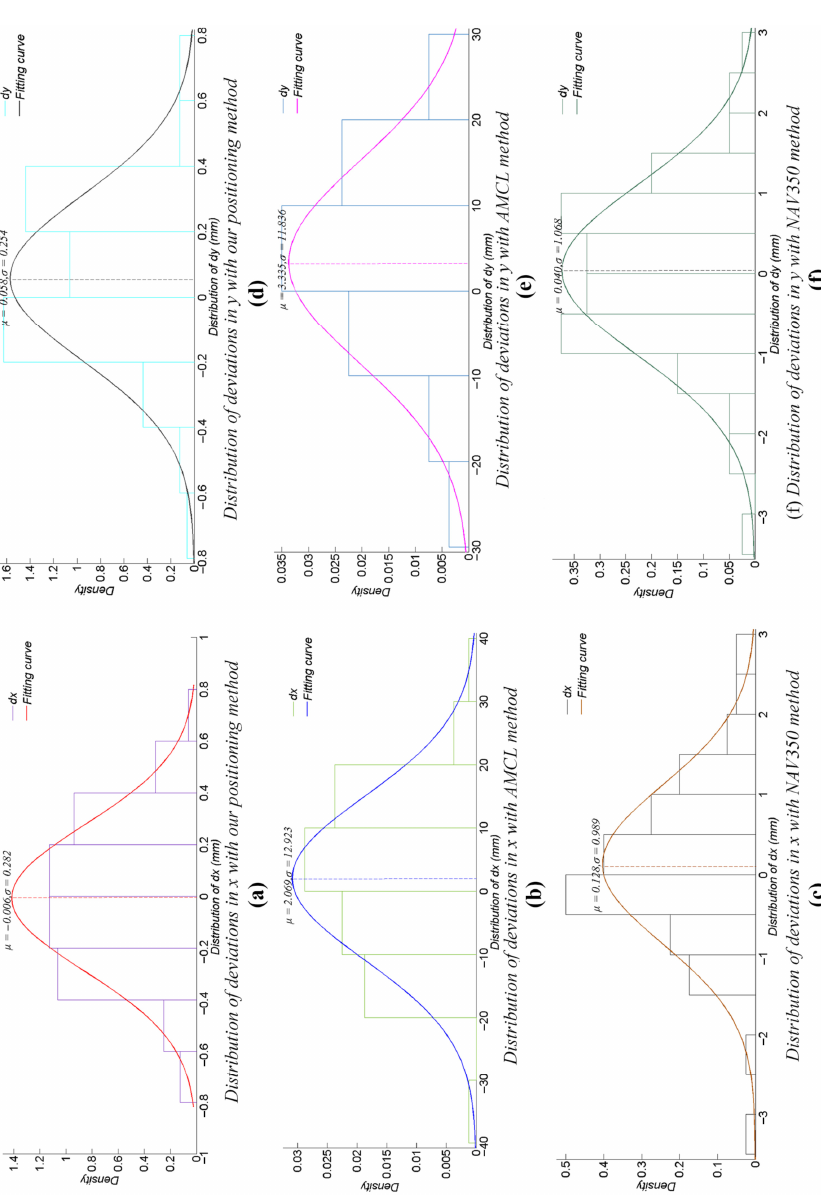
Figure 7. Distributions of deviations in x and y are compared with three different